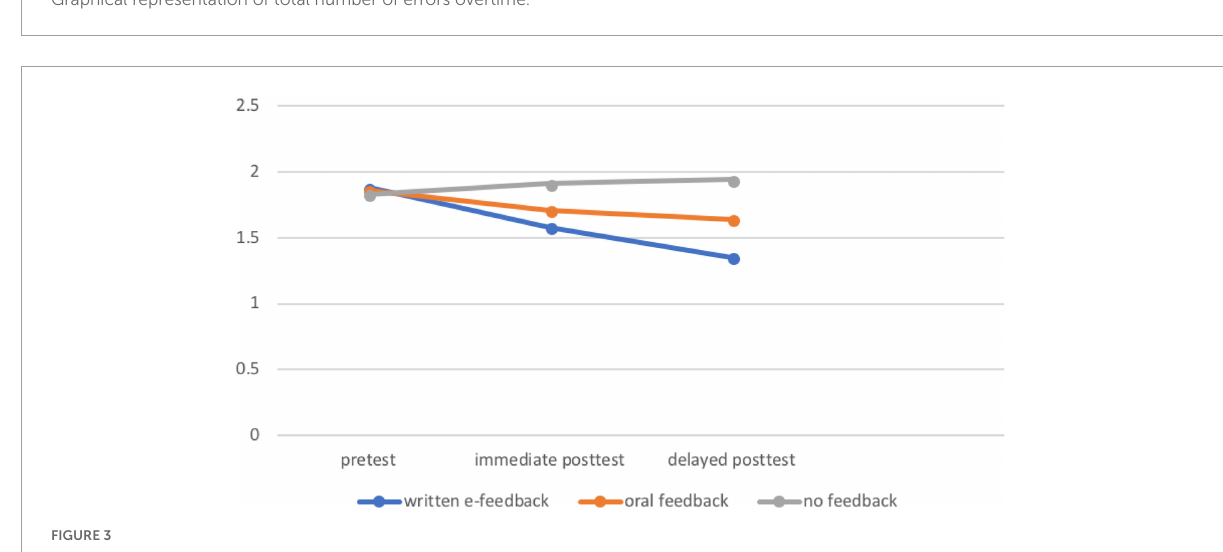
FIGURE2 Graphical representation of total number of errors overtime.